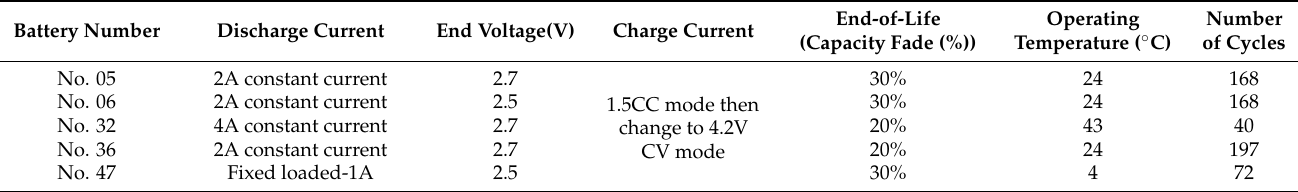
Table 1. This List of batteries with their operating